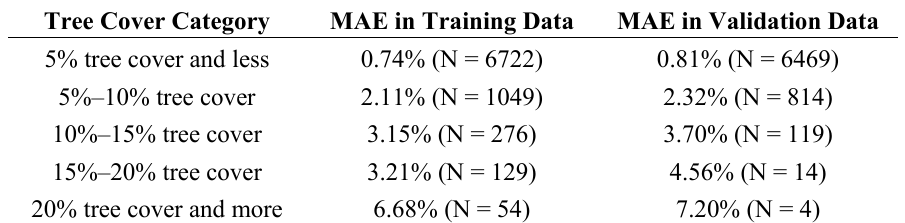
Table 1. Distribution of mean absolute errors (MAE) of estimated tree cover by categories (5% increments of observed/reference tree cover) for training and validation data (N=number of pixels per